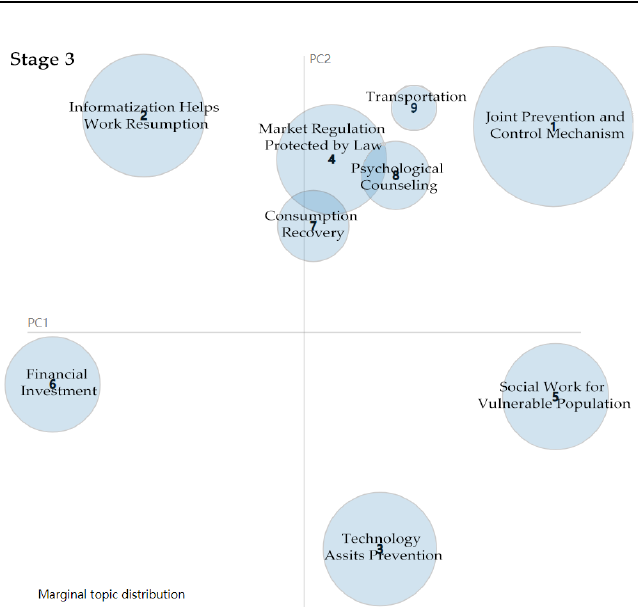
Figure 6. Topic intensity in Stage